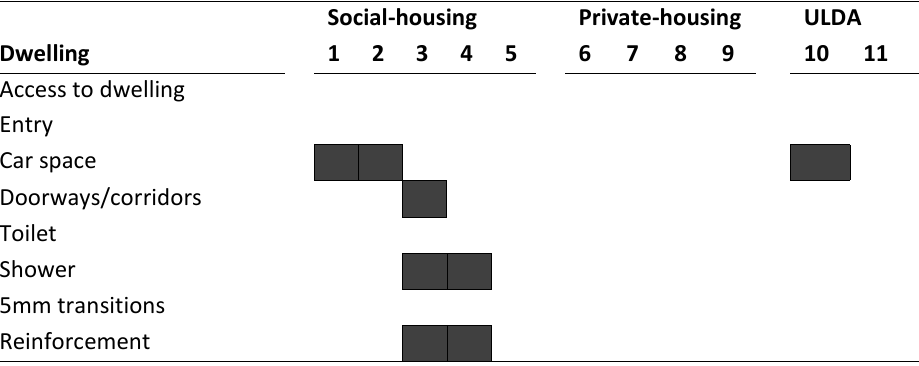
Table 5. Compliant features due to client